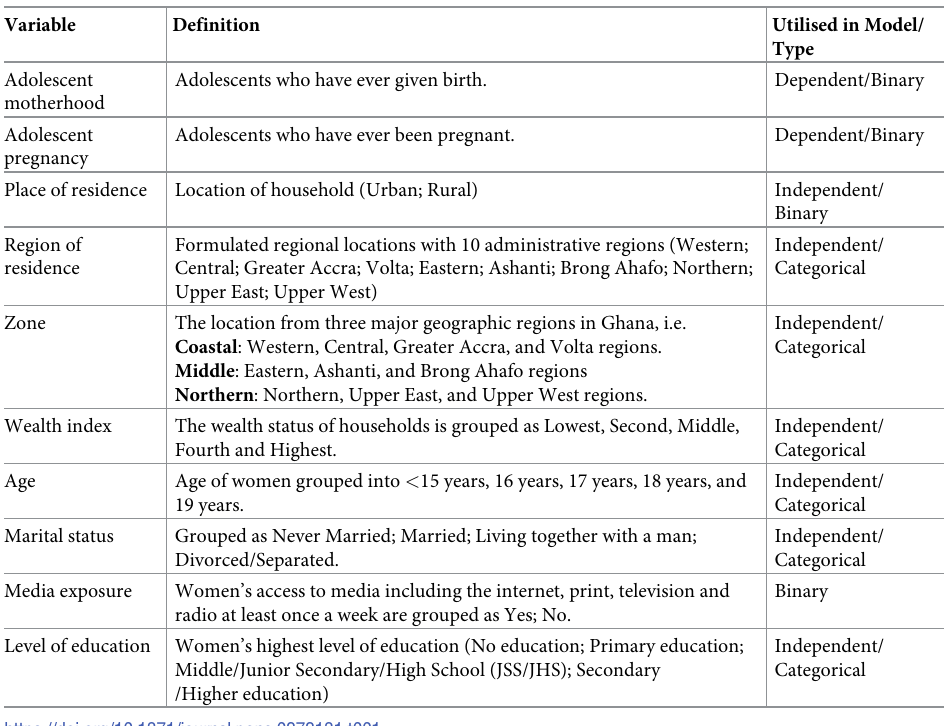
Table 1. Definitions of study variables and their utilisation in models